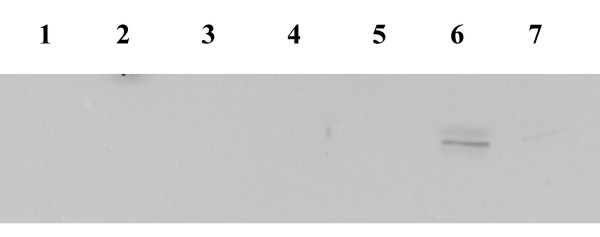
Western blotting of cytochrome c released from mitochondria. Jurkat cells (5 × 105/ml) were treated with Pep27anal2 at 12.5 μM for 1 h, 2 h, and 4 h, and at 62.5 μM for 4 h. Mitochondria were pelleted by centrifugation, and the supernatants retained. As a control, mitochondria were treated with 0.1% (vol/vol) SDS, which induces cytochrome c release from mitochondria. Protein from each fraction was subjected to SDS/PAGE for Western blot analysis using an anti-cytochrome c antibody. 1, the result of analyzing 50 μg of cytosol after adding no Pep27anal2; 2, 50 μg cytosol after 12.5 μM for 1 hr; 3, 50 μg cytosol after 12.5 μM Pep27anal2 for 2 hr; 4, 50 μg cytosol after 12.5 μM Pep27anal2 for 4 hr; 5, 50 μg cytosol after 62.5 μM Pep27anal2 for 4 hr; 6, 50 μg mitosol after 0.1% SDS; 7, 25 μg mitosol after 0.1% SDS.